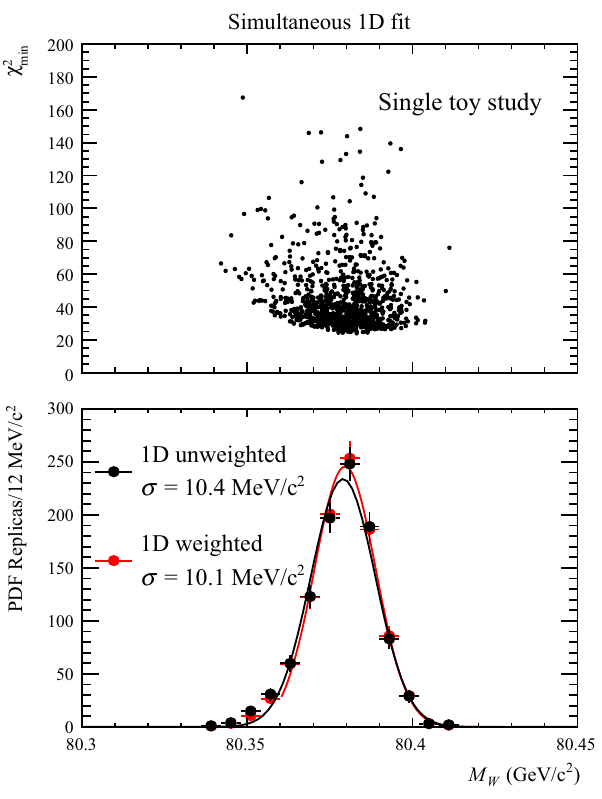
Fig. 12 Upper:thedistributionof χ 2 versus M W foraone-dimensional (left) and two-dimensional (right) simultaneous fit to a single toy dataset,whichassumestheLHCbRun2statistics,witheachofthe1000 NNPDF3.1 replicas. Lower: the extracted M W values, with a Gaussian